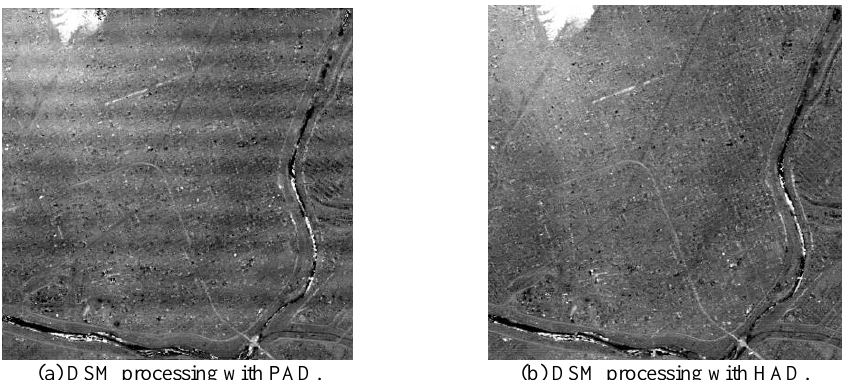
Figure 3. Comparison between the PRISM DSM processed with (a) PAD and (b) HAD (Takaku and Tadono, 2010).